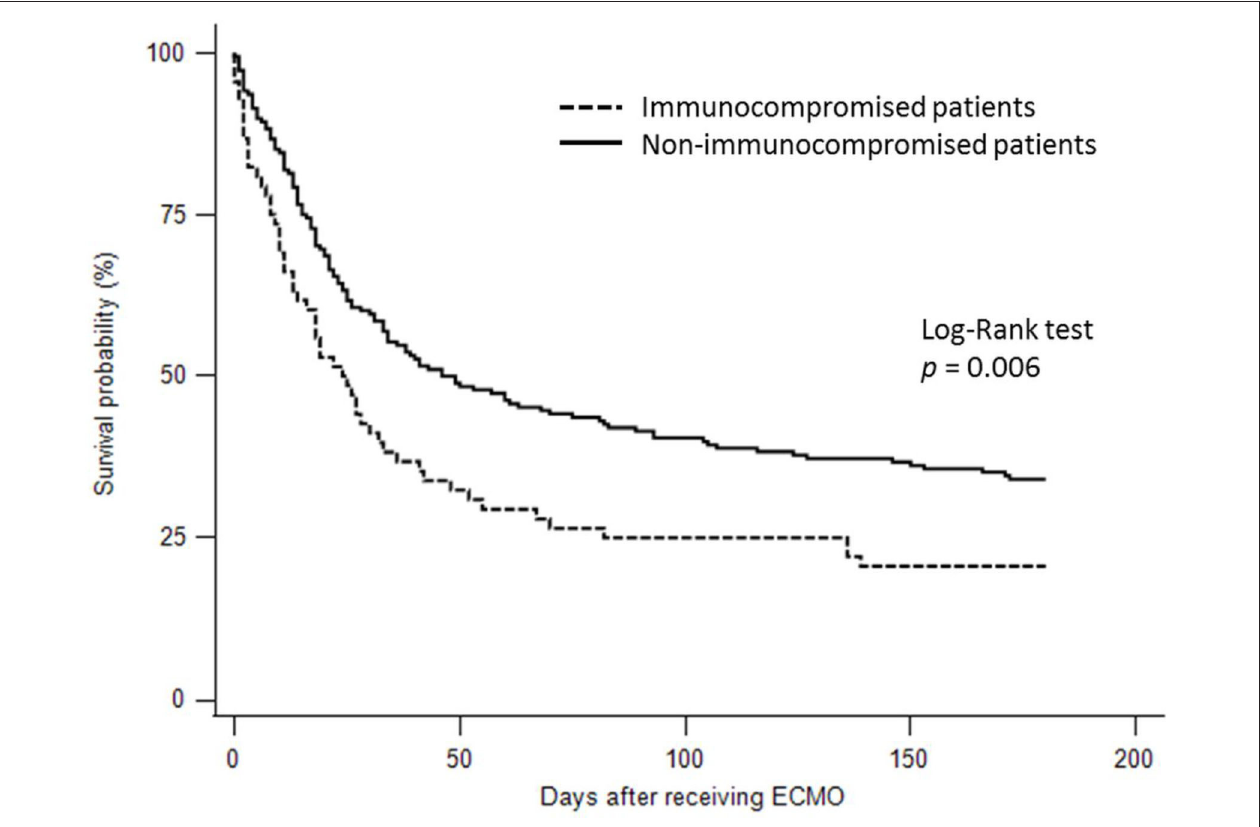
FIGURE 2 | Kaplan-Meier survival curves for 6-month survival in the immunocompromised and immunocompetent patients with acute respiratory distress syndrome treated by extracorporeal membrane oxygenation.